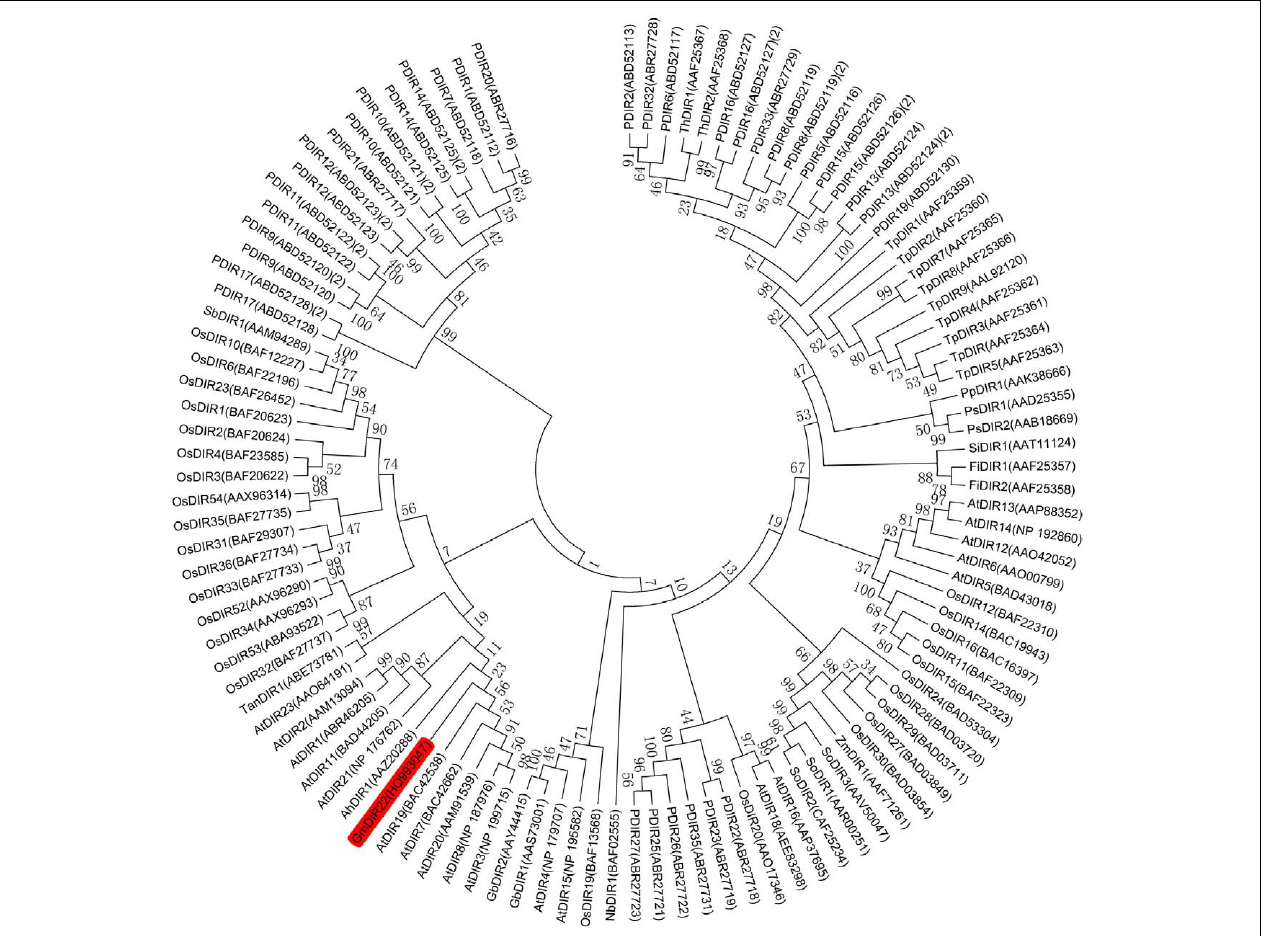
FIGURE 1 | Phylogenetic tree constructed using soybean GmDIR22 nucleotide and DIR or DIR-like nucleotide sequences from various plant species. The nucleotide sequences of 101 dirigent genes were analyzed by neighbor-joining algorithm using Mega 5.1. The stability of internal nodes was assessed by bootstrap analysis with 1000 replicates. DIR nomenclature is as follows: Ah, Arachis hypogaea ; At, Arabidopsis thaliana ; Fi, Forsythia intermedia ; Gb, Gossypium barbadense ; Gm, Glycine max ; Nb, Nicotiana benthamiana ; Os, Oryza sativa ; P, Picea glauca , Picea sitchensis , or P . glauca x engelmannii ; Pp, Podophyllum peltatum ; Ps, Pisum sativum ;